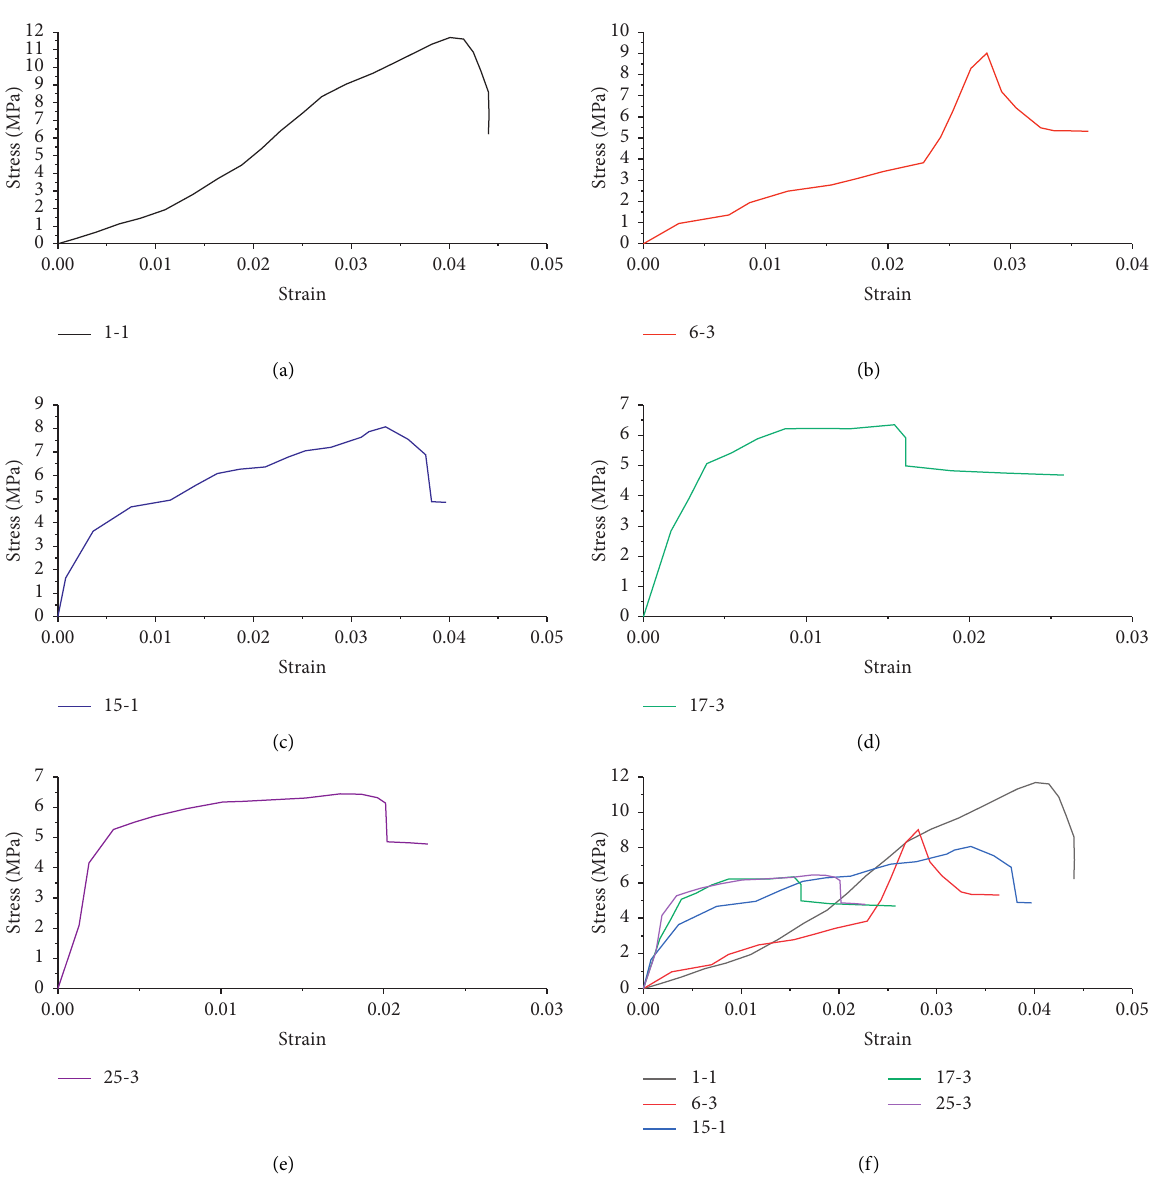
Figure 9: Typical stress-strain curves of uniaxial compression